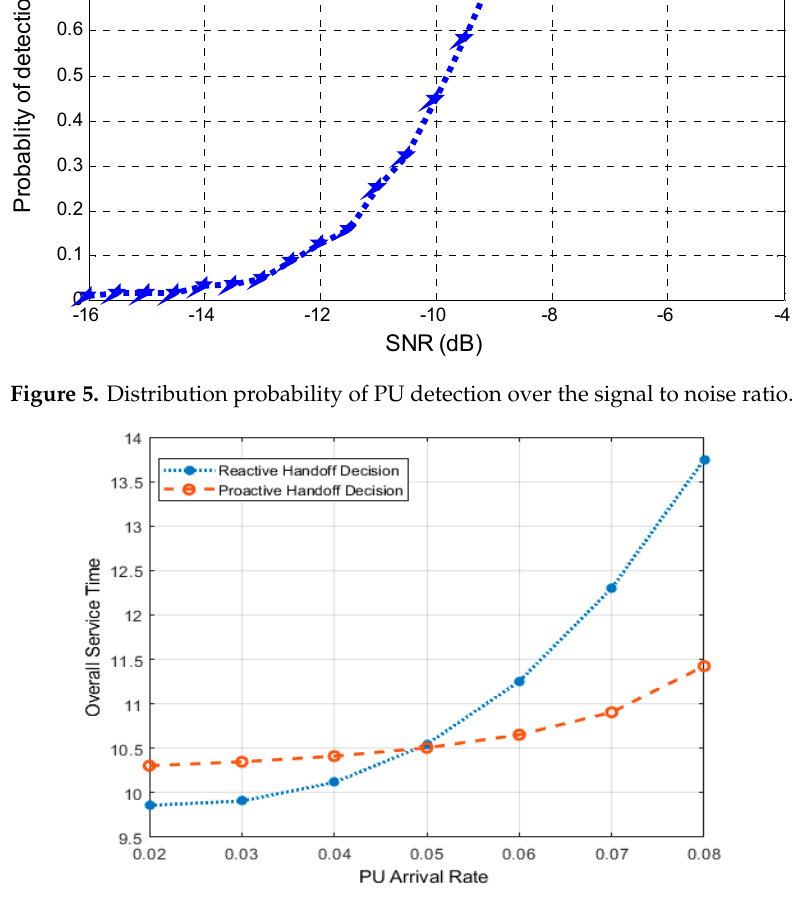
Figure 7. Comparison of primary user traffic pattern-based opportunistic spectrum handoff (PUTPOSH) with reactive and proactive handoffs w.r.t. the overall service time. Number of Handoffs Figure 8 represents the number of handoffs executed by the CRU. The existing handoff strategies, as compared to PUTPOSH, executed an additional quantity of handoffs; during each